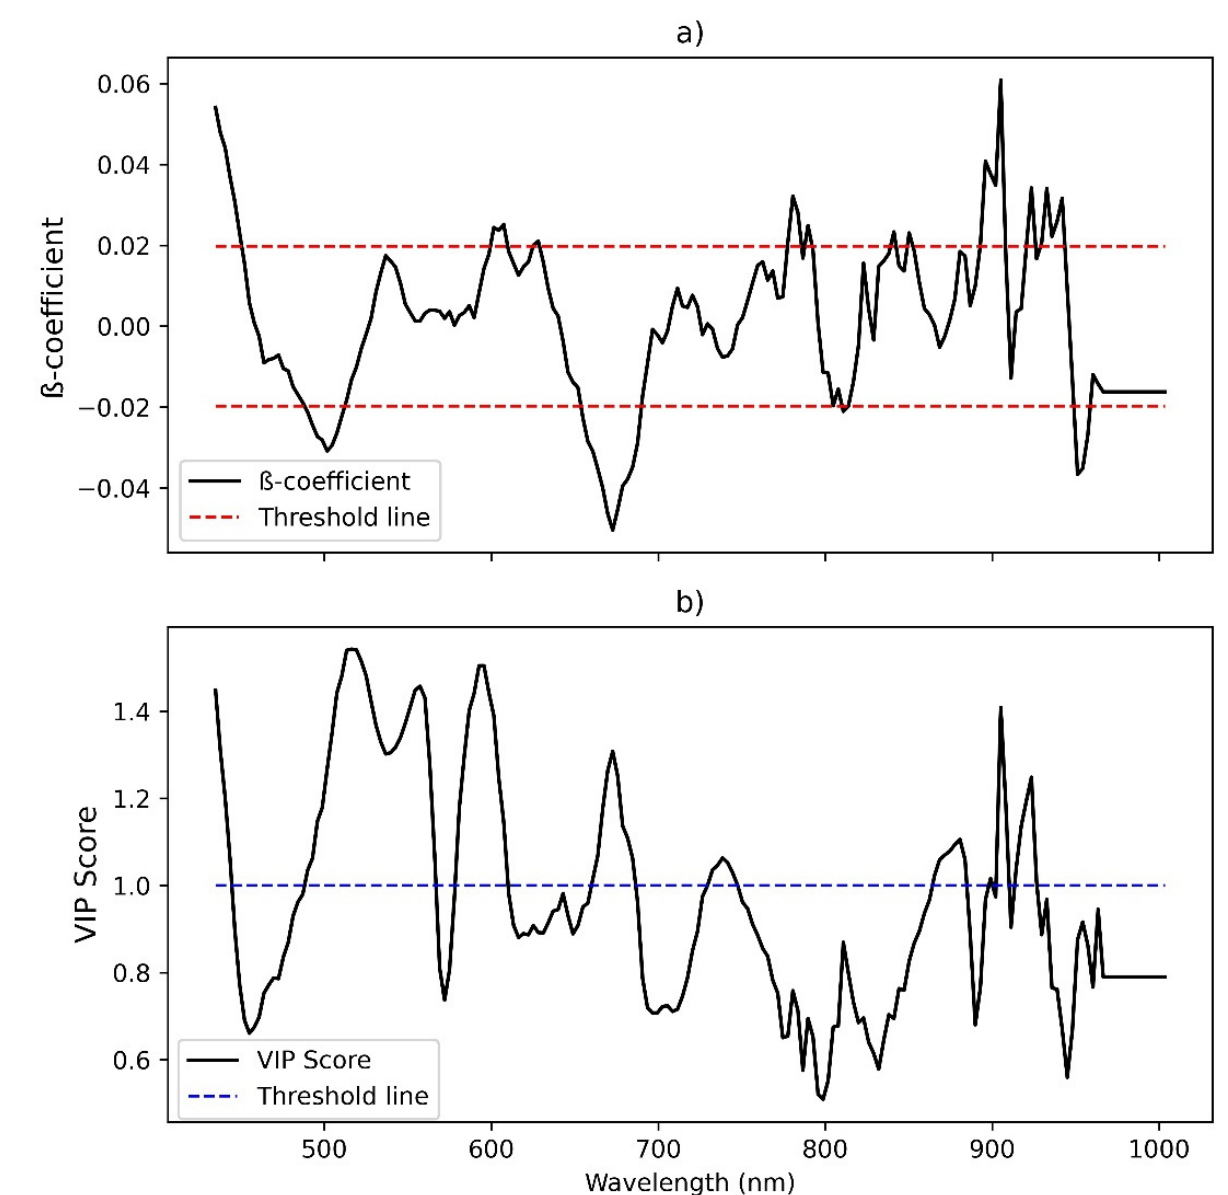
Figure 6. ( a ) β -coefficient for PLSR model III presented in Table S2 (The horizontal red dash lines are threshold lines based on the standard deviation for optimum wavelength selection) and ( b ) VIP score for PLSR model III presented in Table S3 (The horizontal blue dash lines are threshold lines based on the recommended VIP score from the previous study).